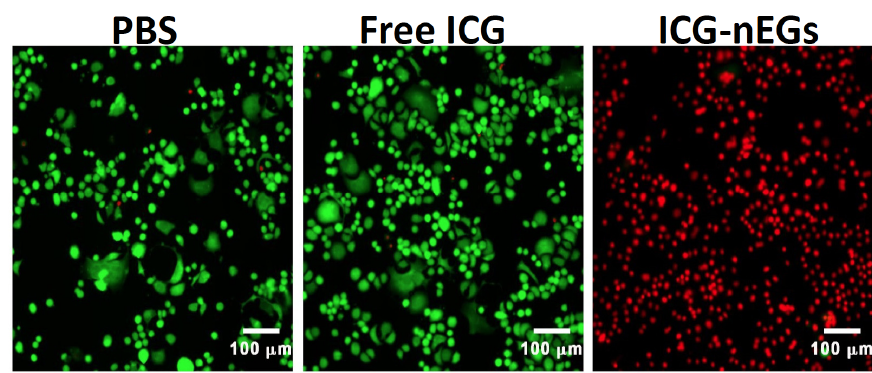
Figure 5. Fluorescence images of SKBR3 breast cancer cells following 808 nm laser irradiation at irradiance of 680 mW/cm 2 for 15 min. Cells were incubated with PBS (negative control), free ICG (positive control), or ICG-nEGs for three hours at 37 °C, and then washed three times before laser irradiation. Live cells are identified by Calcein acetoxymethyl staining, and falsely-colored in green. Dead cells are identified by ethidium homodimer-1 (EthD-1), and falsely-colored in red. Many optical cargos are capable of being used for more than one therapeutic effect.